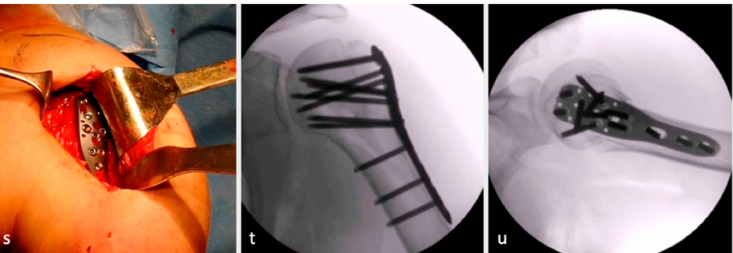
Figure 1. Surgical technique illustration of locking plate osteosynthesis with allograft augmentation. Beach chair positioning ( a ) with image intensifier placed so that true anteroposterior view ( b ) and axial views ( c , d ) are possible. Deltopectoral approach with fracture exposure ( e ). Arming of tuberosities ( f ). Percutaneous, retrograde drilling of K-wires ( g ) up to the fracture line ( h ). Reposition and reduction of head fragments ( i ) and K-wire advancing till subchondral bone ( j ). Osseous defect due to fracture visible ( k ) and augmention with allograft ( l ). Treatment of bicep tendon ( m ) followed by tuberosity refixation ( n ). Angular locking plate placed in situ ( o ) and fixed temporarily with K-wires ( p ). Drilling from top to bottom ( q ) followed by screw placement ( r ). Final evaluation for stability and impingement in situ ( s ) and under image intensifier in true anteroposterior ( t ) and axial view ( u ). (Reproduced, with modification, under Creative Commons Attribution 4.0 International.